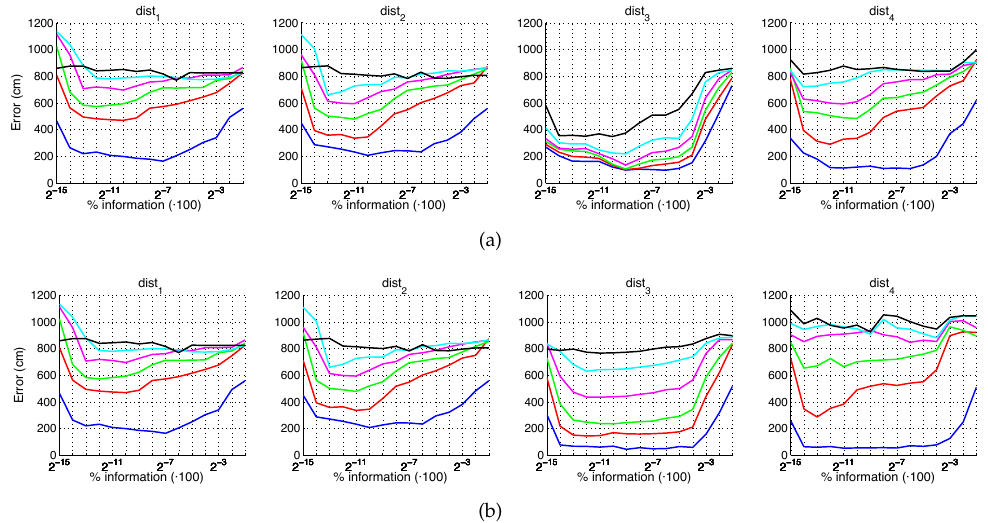
Figure 22. HOG average localization error with noise: ( a ) no filter and ( b ) homomorphic